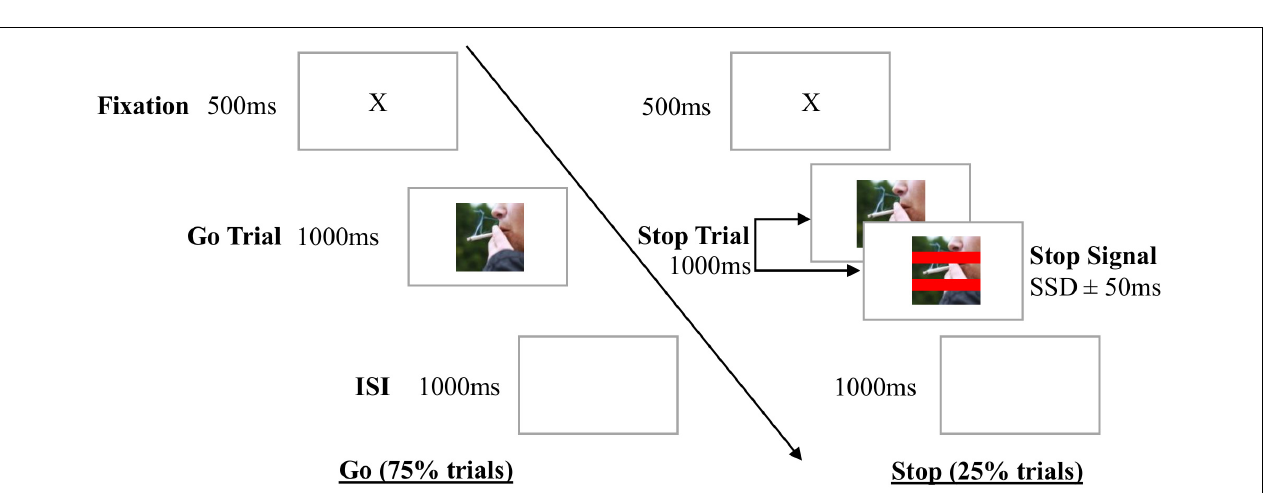
FIGURE 2 | Stop Signal Task (SST). Go stimuli were eight pairs of images of smoking, with one image presenting the cigarette pointing left, and the other its mirror image- with the cigarette pointing right. Each SST begun with a practice block of 10 trials, followed by a test block of 192 trials. After a fixation cross, participants were presented with an image of smoking, followed by an inter-stimulus interval (ISI). Participants were instructed to indicate whether the “lit” or “burnt end” of the cigarette was pointing left or right by pressing a computer key. If red lines (stop signal) appeared across the image, participants were instructed to not respond (stop trials, 25% trials). The stop signal appeared at a short delay (stop signal delay or SSD) after the go stimulus, which began at 250 ms on the first stop trial, and then adjusted by 50 ms in a staircase manner (increased after successful stop trials, or decreased after failed stop trials) so participants had approximately 50% accuracy and converged on a mean